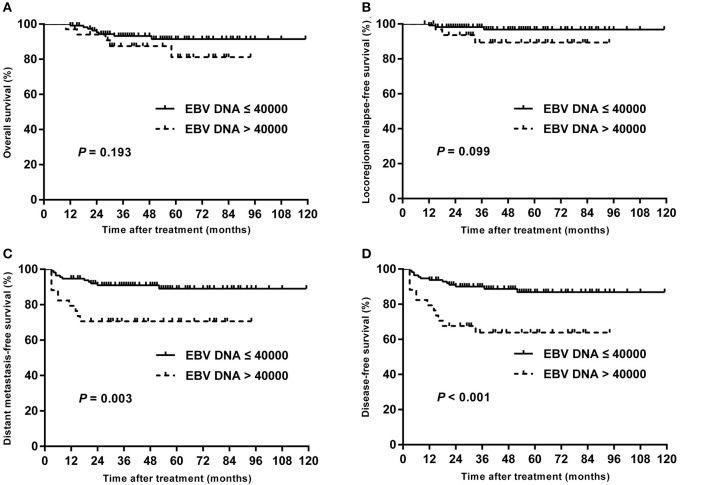
Kaplan–Meier estimate of the OS (A), LRRFS (B), DMFS (C), and DFS (D) of children and adolescent NPC patients according to pretreatment EBV DNA levels.